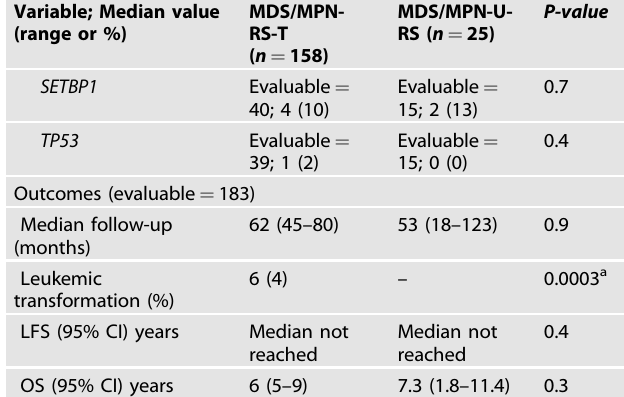
( n = 25), so as to inform future revisions of the WHO classi fi cation of myeloid malignancies.